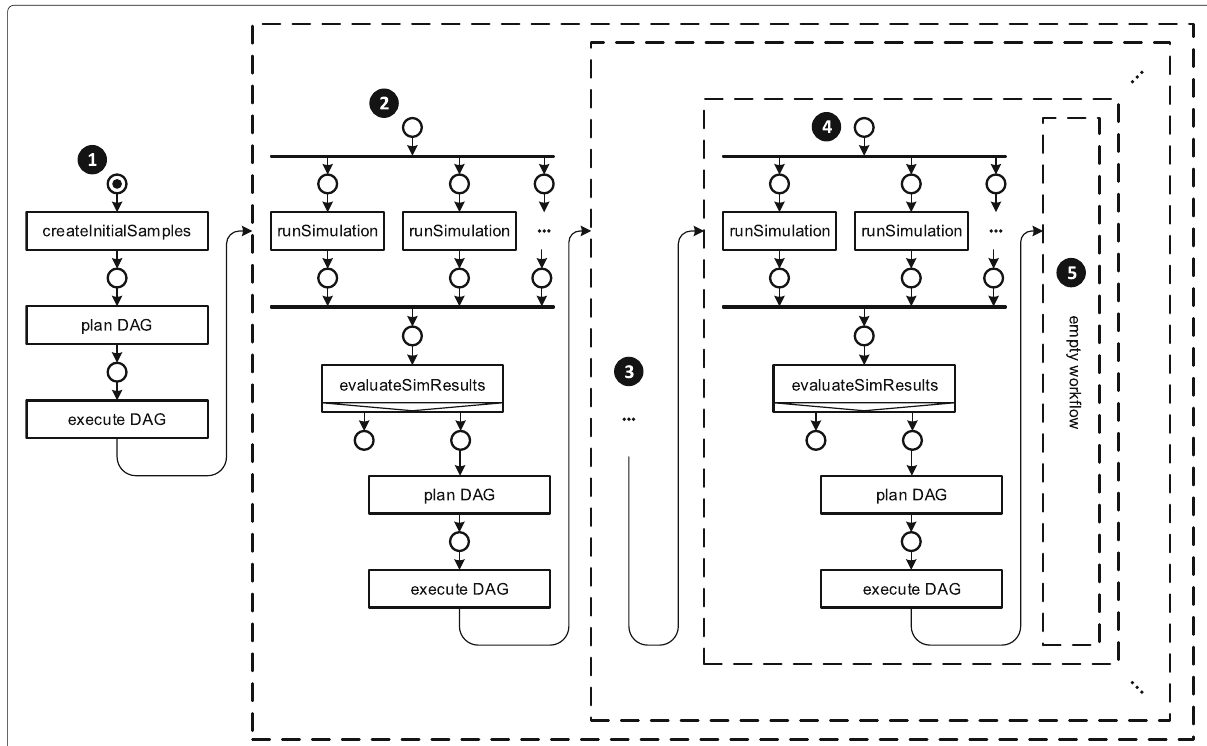
Fig. 22 Implementation of the shape optimisation in